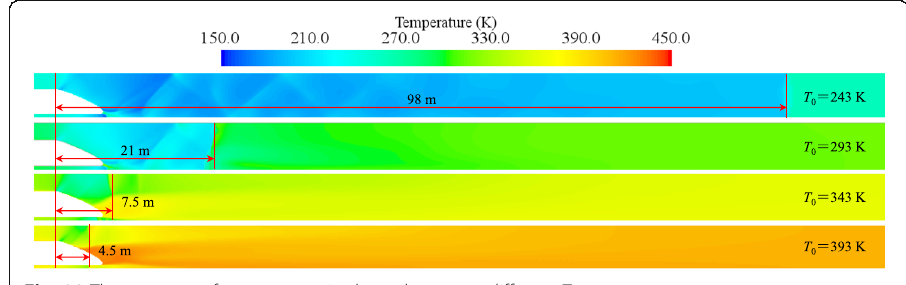
Fig. 20 The contours of temperature in the wake area at different T